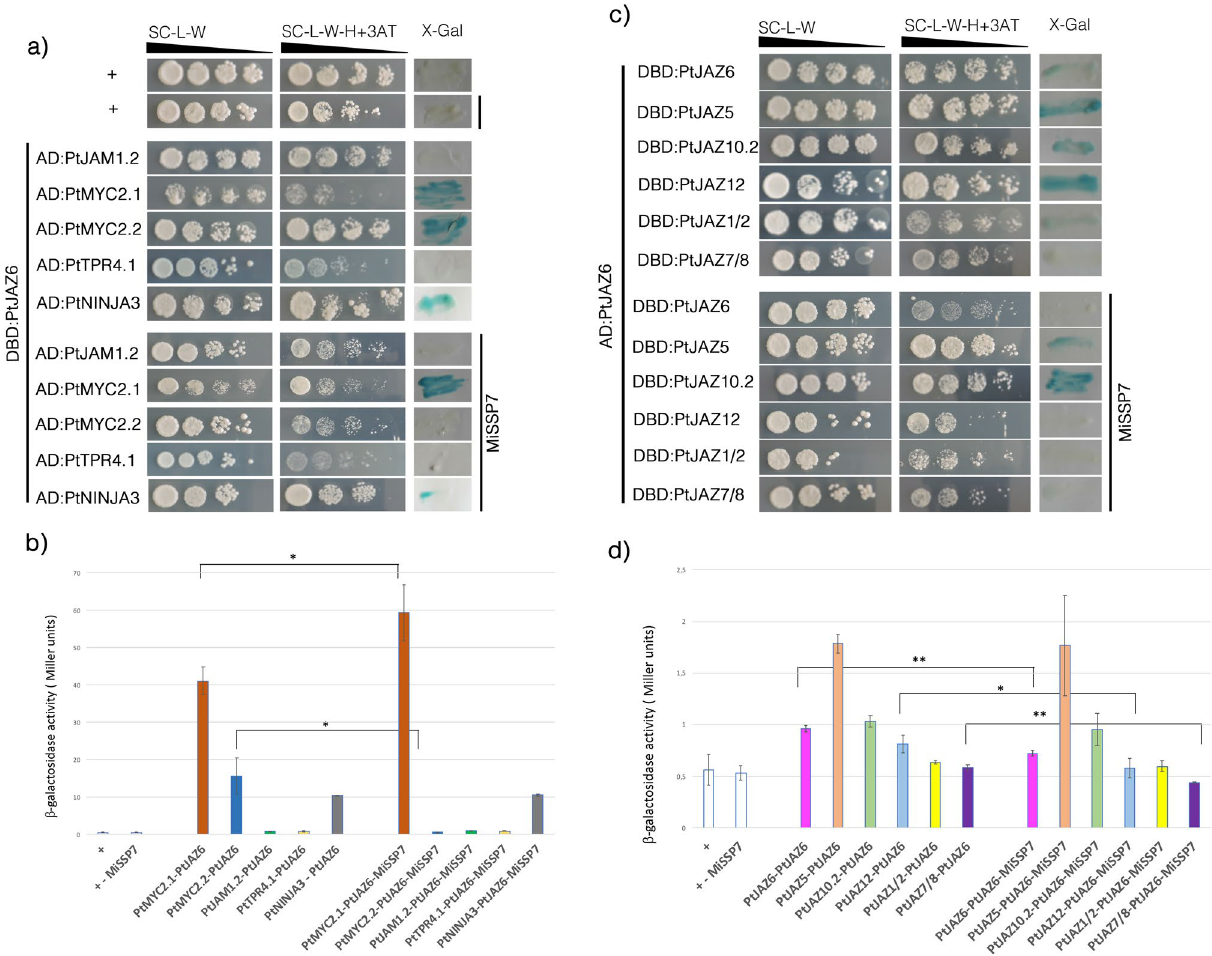
Figure 5. MiSSP7 impacts the structure of the jasmonate perception complex. ( a , b ) MiSSP7 differentially impacts the interaction between PtJAZ6 and the two isoforms of PtMYC2 but does not alter PtJAZ6-PtJAM1.2 or PtJAZ6-PtTPR4.1 interactions. PtJAZ6 was fused to the GAL4 DBD. PtMYC2s, PtJAM1.2, PtNINJA3 and PtTPR4.1 were fused with the GAL4 AD. ( c , d ) MiSSP7 antagonizes dimerization between PtJAZ6 and other PtJAZ proteins. PtJAZ6 was fused to the GAL4 AD and PtJAZ proteins were fused with the GAL4 DBD. For a) and c), yeasts were transformed with MiSSP7 to give triple hybrids. TRP1 , LEU2 and URA3 served as transformation markers (the latter in case of triple hybrid colonies) while HIS3 and β -galactosidase LacZ (X-Gal) were used as reporter genes. 3-Amino-1, 2, 4-triazole (3-AT) was used to suppress self-activation of the HIS3 gene. The control colonies are shown in the upper part of the panel: + is a weakly interacting pair. For b) and d), the enzymatic activity of the β-galactosidase in different yeast colonies was quantified via ONPG assay. Significant differences between yeast colonies transformed or not with MiSSP7 were assessed via pairwise Student’s t-test (*p < 0.05, **p < 0.01). White lines indicate cropped and repositioned images while the full-length blots and gels are presented in Supplementary Information